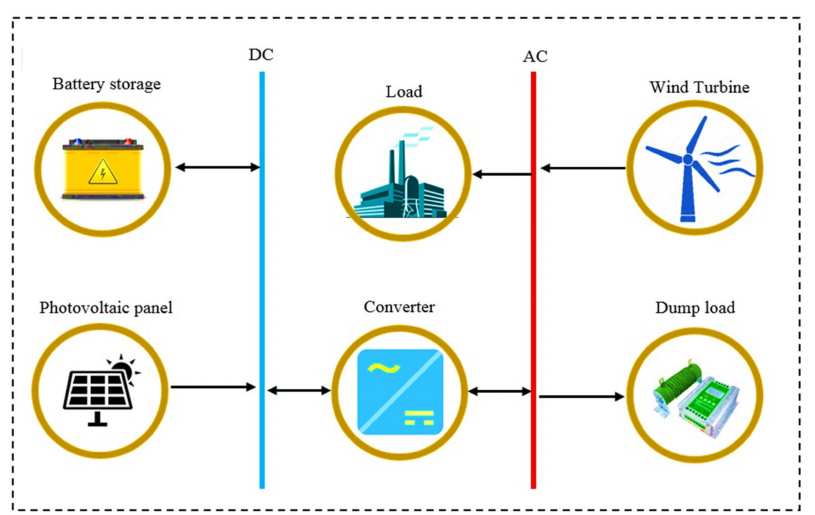
Figure 1. General schematic of the photovoltaic panel/wind turbine hybrid microgrid with direct current (DC) bus and alternating current (AC)